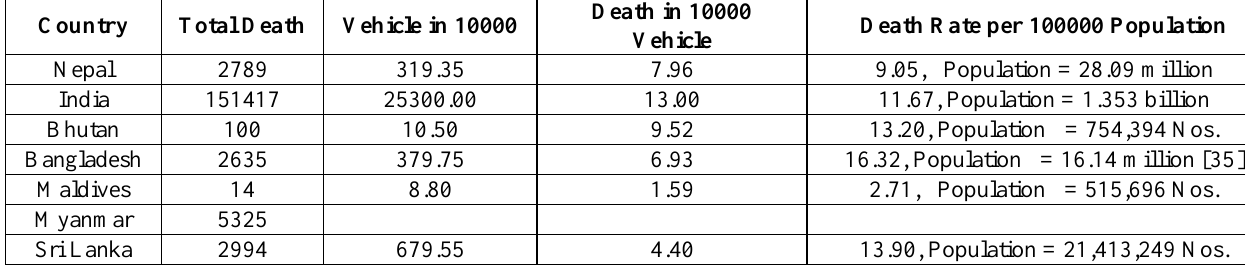
Table 32: Comparison of Road Safety